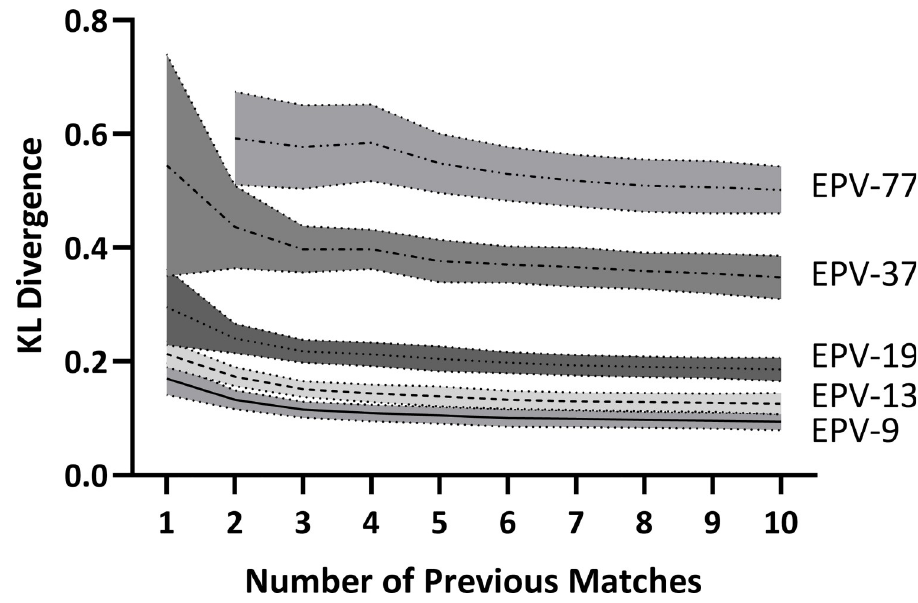
Fig 3. KL Divergence values for EPV-77, EPV-37, EPV-19, EPV-13 and EPV-9. A lower value indicates greater similarity in reward distributions between previous matches and the subsequent match. EPV-308 not included as values could not be calculated for the first seven matches due to no non-infinity values being present. Line provides mean value, shaded area indicates standard deviation. model. Relative to the average Super League team, team 4 gained greater proportion of match EPV from wider areas 10-70m from their try line. Conversely, teams 6 and 8 gained a greater proportion of match EPV attacking centrally (zones 5–7 for team 6, zones 5–6 for team 8). Within 20m of the opposition try line, team 9 gained a lower proportion of match EPV from the widest zone (zone 14), but the spread of their match EPV over the more central areas was much more even than other teams.